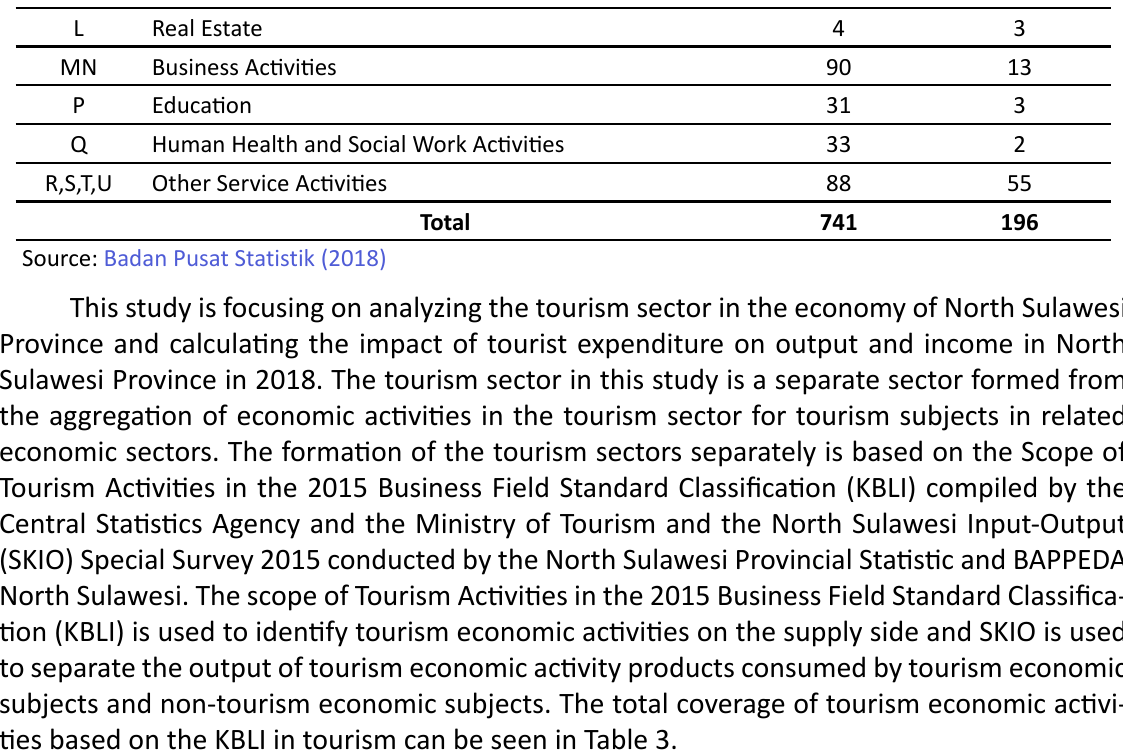
Total Tourism Total Economic Activities